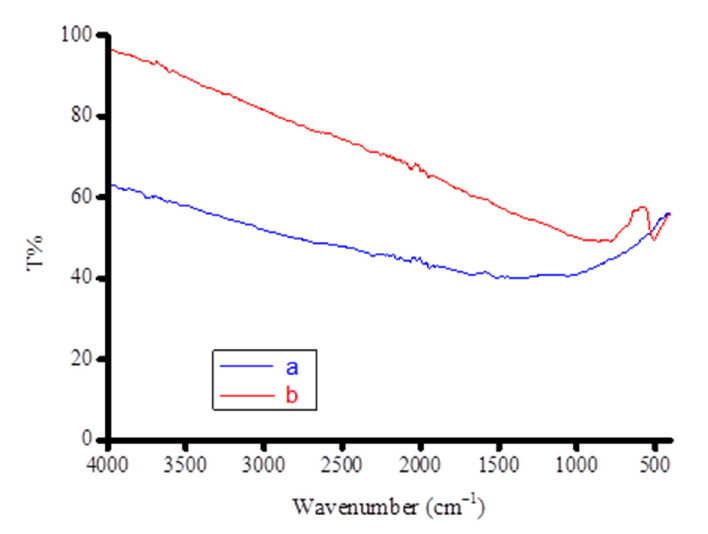
Figure 8. IR spectra of (a) the multi-walled fullerene carbon nanotube (CNT) and (b) the synthesized CrFeO 3 -CNT adsorbent material.